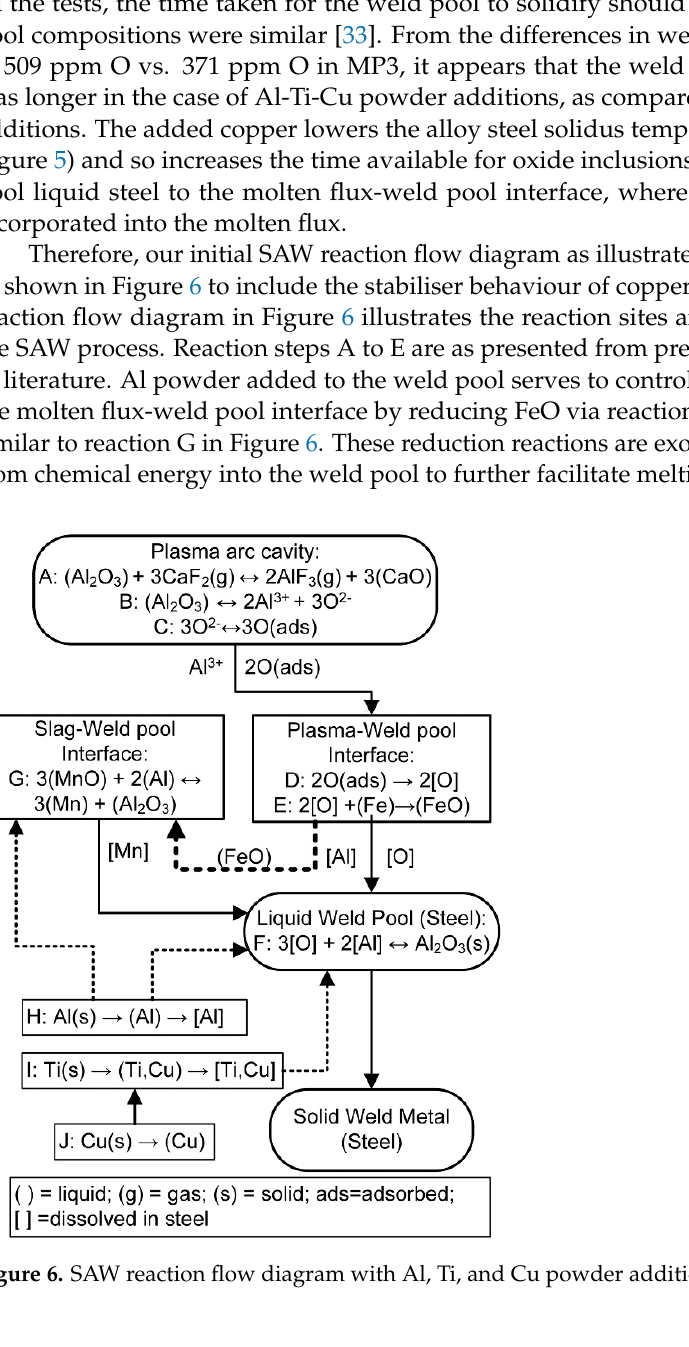
equilibria. The reduced oxygen potential at the molten flux-weld pool interface prevents oxidation of Ti powder to Ti-oxides, and ensures that the Ti is melted with Cu and then dissolved into the weld pool, reaction I. Since there is an excess of Al added, some of the Al also dissolves into the weld pool (reaction H). Both dissolved Ti and Al react with ox- ygen in the steel to form inclusions (reaction F). Reactions I and J illustrate the role of Cu as stabiliser whereby Cu first forms a low temperature alloy with Ti to decrease the tem- perature required for melting Ti into the weld pool. The results presented here confirm that the oxygen potential at the molten flux-weld pool interface is sufficiently controlled by Al powder addition, even when Cu powder is added to the weld pool. The lowered oxygen potential at the molten flux-weld pool inter- face enhances Ti powder transfer into the weld pool, without interfering with oxygen transfer from the plasma arc to the weld pool. Copper metal powder addition to the weld pool acts as a stabiliser metal by lowering the Ti liquidus temperature from 1660 °C to as low as 1265 °C. The copper metal powder added to the weld pool serves as stabiliser of Ti in the weld pool by decreasing the temperature required for melting Ti into the weld pool. 5. Conclusions 1. The results presented here confirm that the oxygen potential at the molten flux- weld pool interface is sufficiently controlled by Al powder addition, even when Cu pow- der is added to the weld pool. 2. The oxygen potential was controlled by Al addition without interfering with oxy- gen transfer from the plasma arc to the weld pool, resulting in 371 ppm O in the weld metal vs. 509 ppm O in the absence of Cu powder addition. 3. The Cu metal powder added to the weld pool serve as stabiliser of Ti in the weld pool by decreasing the temperature required for melting Ti into the weld pool.